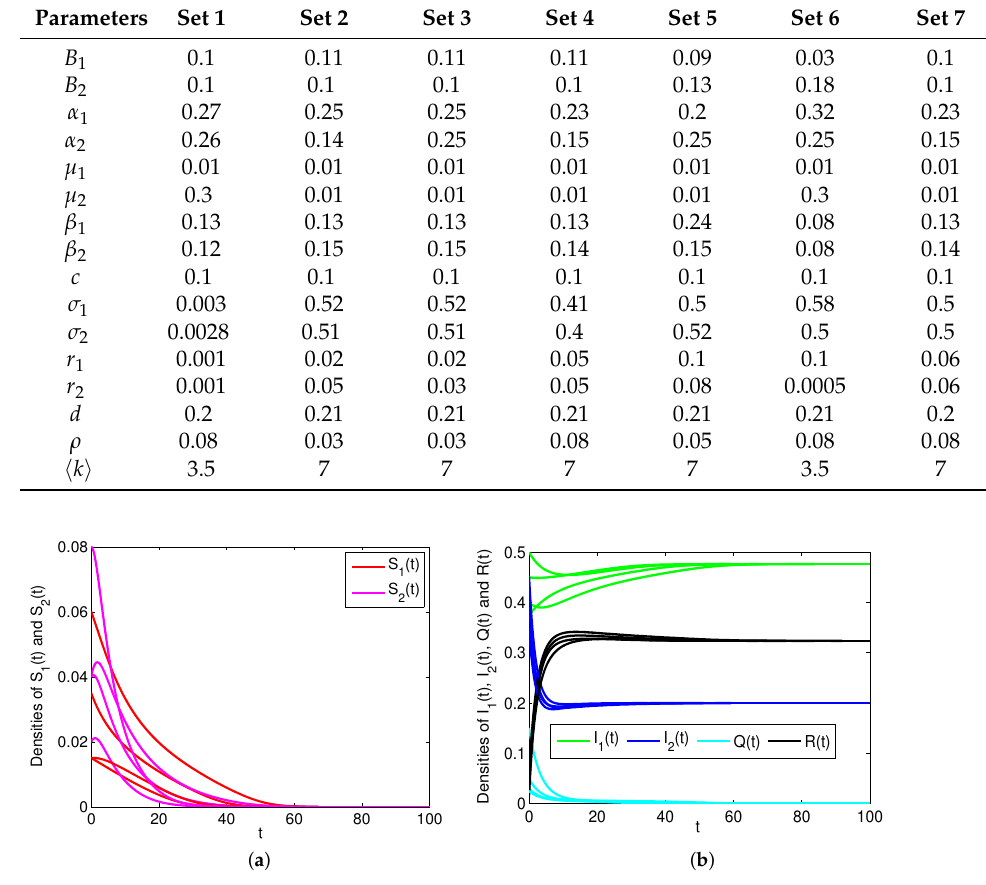
Figure 3. The dynamics of system (1) with (cid:60) 0 < 1. ( a ) The trajectories of S 1 ( t ) and S 2 ( t ) . ( b ) The trajectories of I 1 ( t ) , I 2 ( t ) , Q ( t ) and R ( t ) .